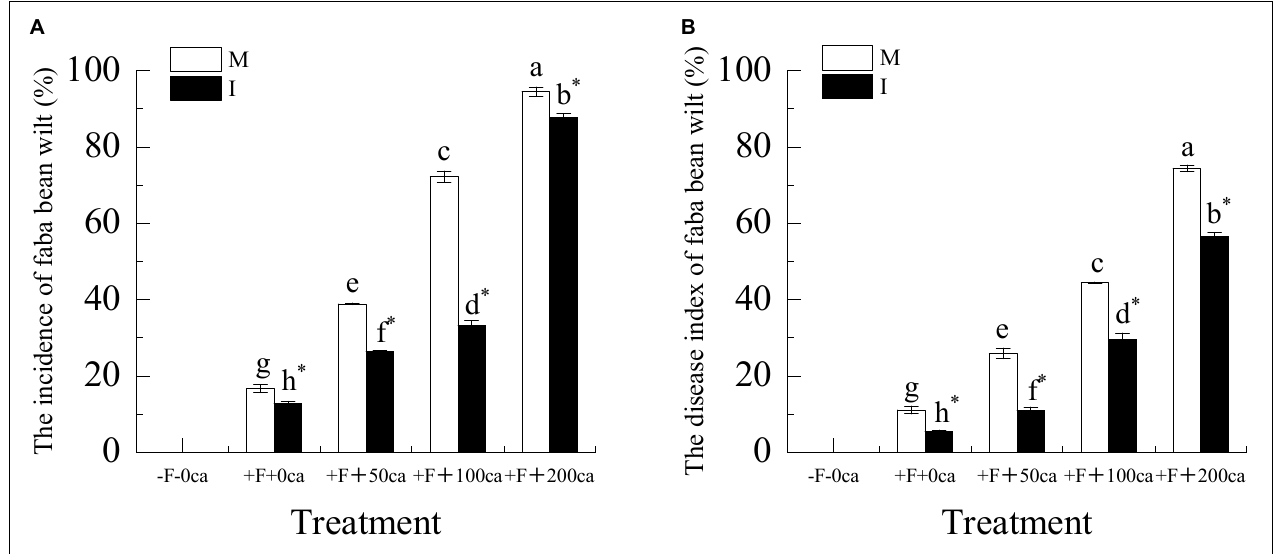
FIGURE 2 | Effects of FOF and cinnamic acid stress on faba bean wilt and the intercropping effect. (A) The incidence of faba bean wilt, (B) The disease index of faba bean wilt. Values in the figure are the mean ± standard error. Different lowercase letters after the data indicate a significant difference ( P < 0.05). ∗ Significant differences between monocropping and intercropping treatments with the same FOF and cinnamic acid levels ( P < 0.05). ca, cinnamic acid; F, Fusarium wilt; FOF, Fusarium oxysporum f. sp. fabae ; I, intercropping; M,